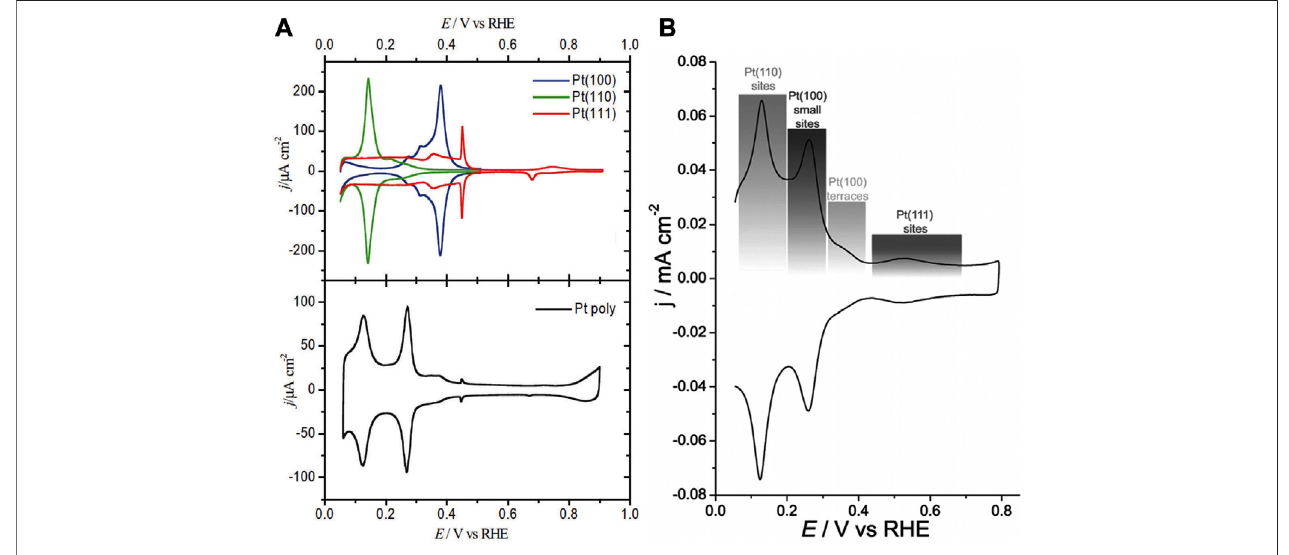
FIGURE4| Thecyclicvoltammetry ofthesurfaceofcrystallinePt fi lminthe0.5 Msulfuricacidelectrolyteat thesweeprateat50 mV/s. (A) Singlecrystalline Pt. (B) Polycrystalline Pt. (A,B) Reproduced with permission (Gómez-Marín et al., 2014; Strasser et al., 2018). Copyright 2018, Royal Society of Chemistry.